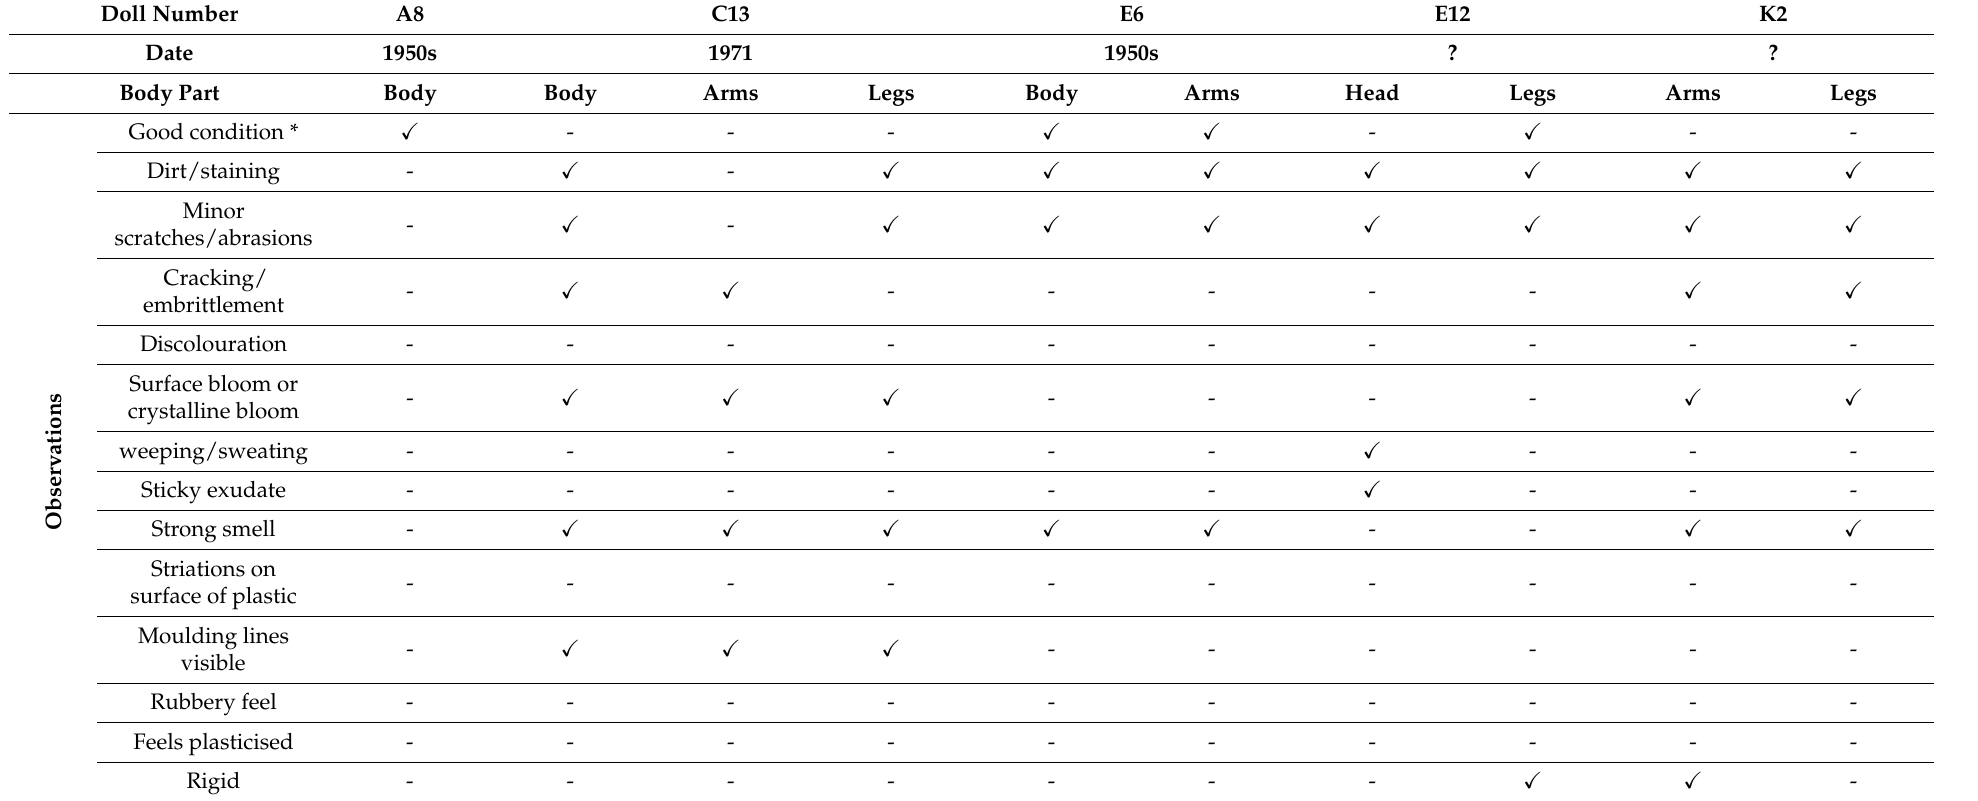
Table 2. Summary of condition of the dolls identified as having CA